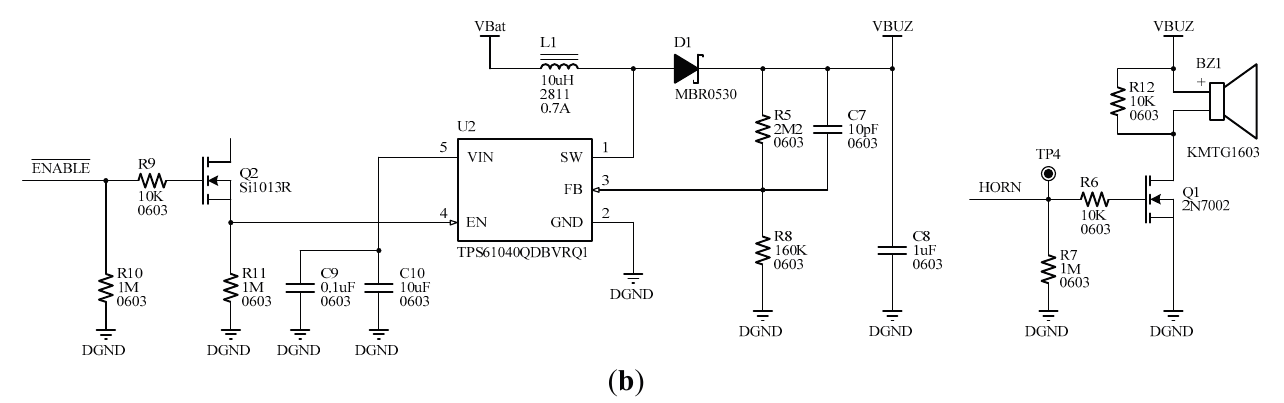
Figure 8. ( a ) Scheme of capacitive sensor for the touch pad; ( b ) Schematic circuit for the